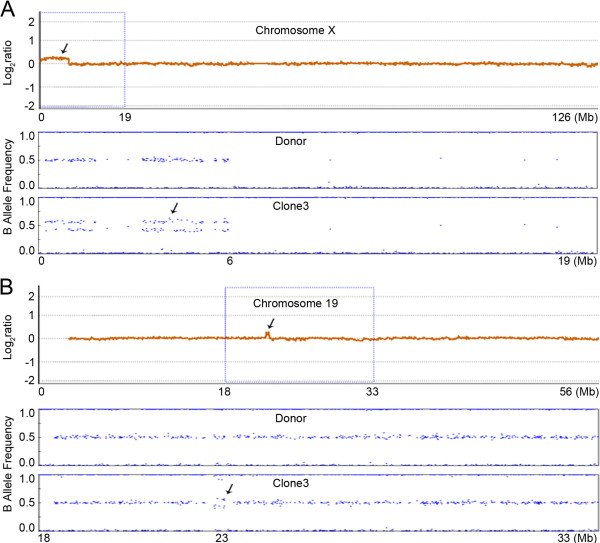
Examples of allelic imbalance in clone-3. (A) Upper panel, Log2ratio plot on chromosome X in clone 3. A 5.2-Mb copy number gain region on chromosome X was identified in clone-3 (black arrow). The X-axis represents genomic position (Mb) and the Y-axis represents signal intensity ratio on a log2 scale. Lower panel, B-allele plot of the proximal part of chromosome X (dashed box of upper panel). A heterozygous cluster was detected in chromosome X (black arrow), and this allelic imbalance has the same genomic position as the copy gain region. (B) Upper panel, Log2ratio plot on chromosome 19 in the clone-3. A 338-Kb copy number gain region on chromosome 19 was identified in clone-3 (black arrow). Lower panel, B-allele plot of the dashed box on chromosome 19. A heterozygous cluster was detected on chromosome 19 (black arrow), and this allelic imbalance has same position as the copy gain region.